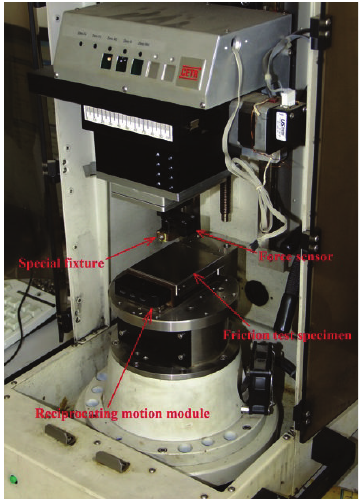
Figure 3: A UMT-2 type friction